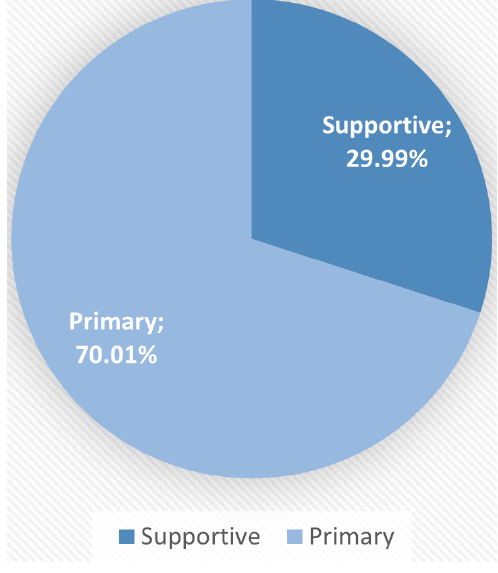
Figure 15. ML’s role in